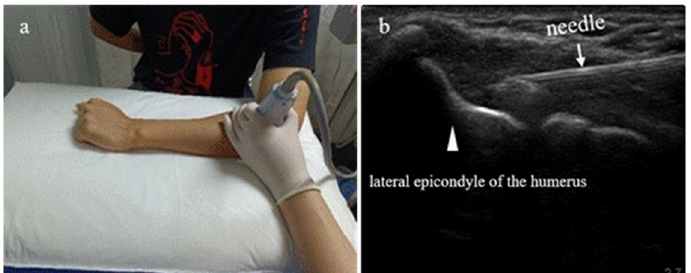
Figure 3. Summary of ultrasound-guided platelet-rich plasma (PRP) injection. Patient with refractory lateral epicondylitis sitting in front of a table with his forearm on it. ( a ) Ultrasound images of the radial head, the lateral epicondyle of the humerus, and the surrounding soft tissues obtained with a 13–6 Mhz probe. ( b ) Ultrasound-guided PRP administration into the injured common tendon of the external epicondyle of the humerus.